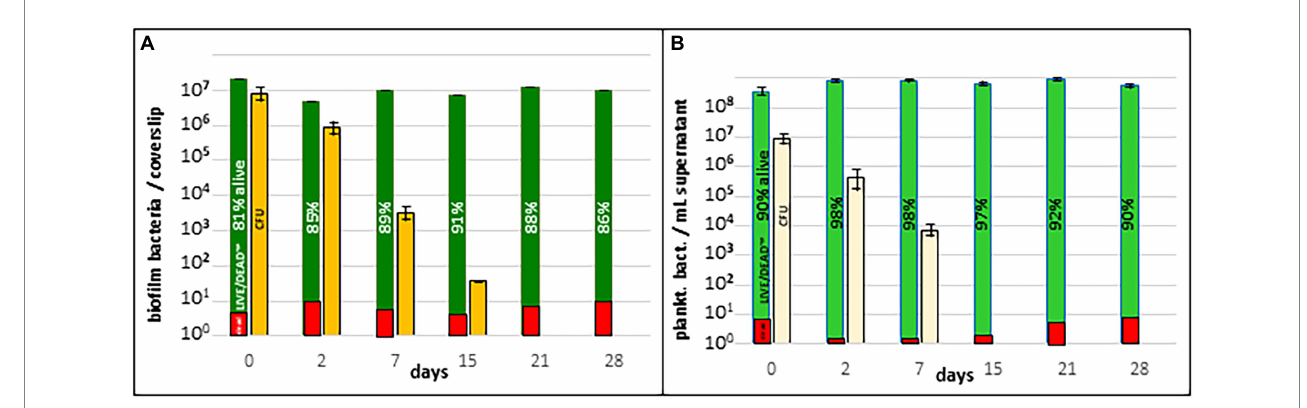
FIGURE 2 Survival of Fth in natural water. (A) Survival of Fth biofilm in natural water. (B) Survival of planktonic Fth bacteria in natural water. Fth biofilm and respective planktonic cells were incubated in natural water and investigated if the bacteria are still cultivable (CFU) and viable (Live-Dead staining). The results represent the average of two